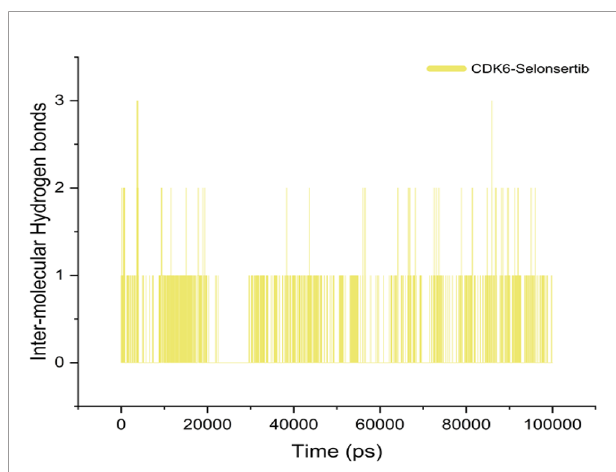
FIGURE 4 | Intermolecular H-bonds in the Selonsertib-CDK6 complex during MD simulation.